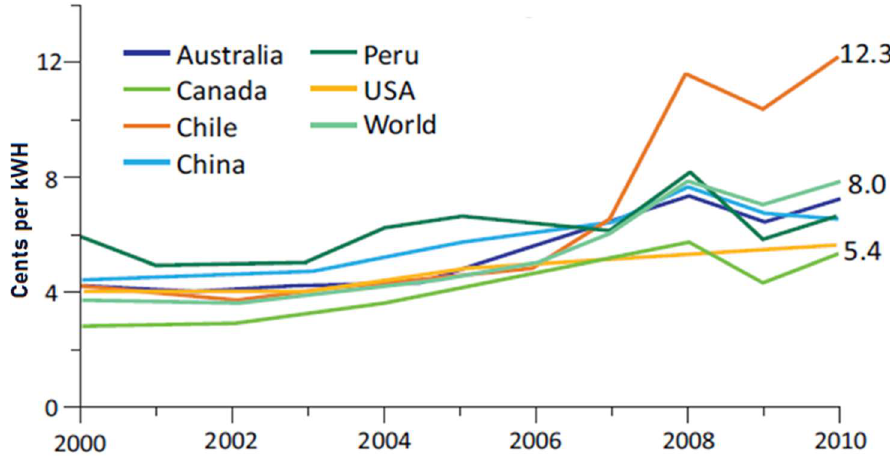
Figure 1. The energy costs for some mining countries in the world. Reproduced with permission from CSIRO Chile, The Future of Mining in Chile; published by CSIRO, 2014 [14].